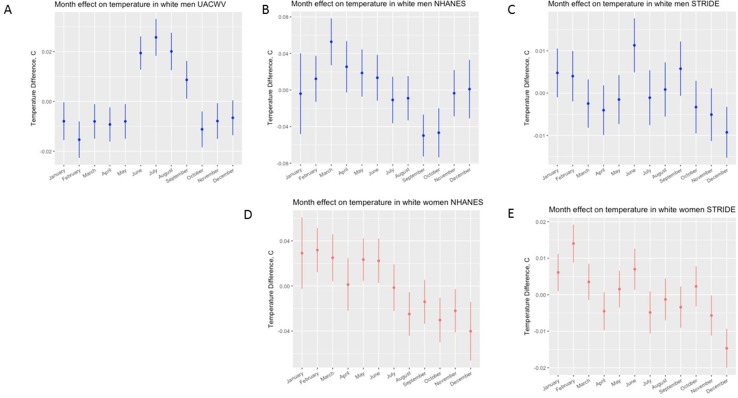
Effect of the month of temperature measurement.Mixed effect predictions and confidence intervals of the month during which the measurement was taken on the measured temperature. (A) White men in UACWV, (B) white men in NHANES I, (C) white men in STRIDE, (D) white women in NHANES I, and (E) white women in STRIDE.Figure 1—figure supplement 5—source code 1.R code for Figure 1—figure supplement 5.